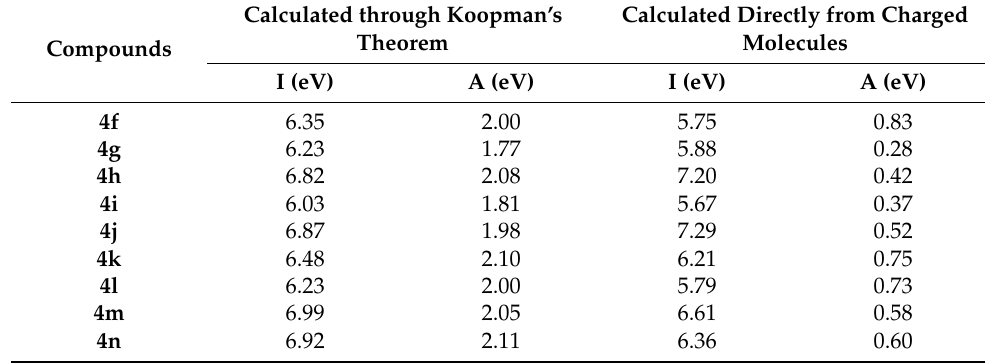
Calculated through Koopman’s Theorem